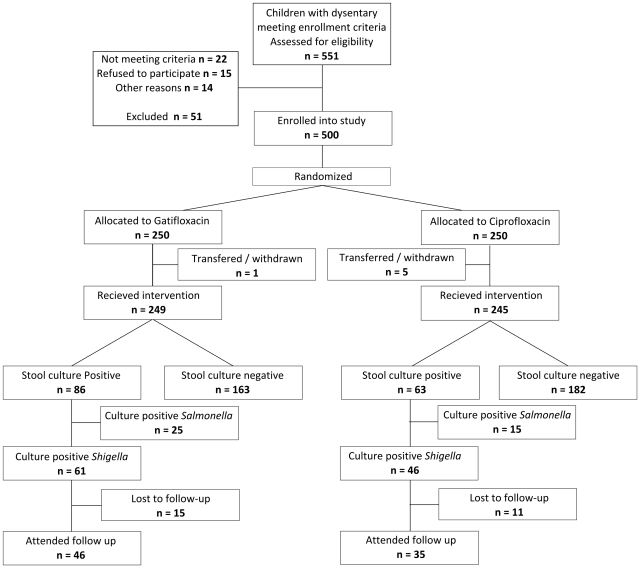
Profile for the gatifloxacin versus ciprofloxacin shigellosis treatment trial.The CONSORT flow diagram showing the flow of participants throughout the trial.